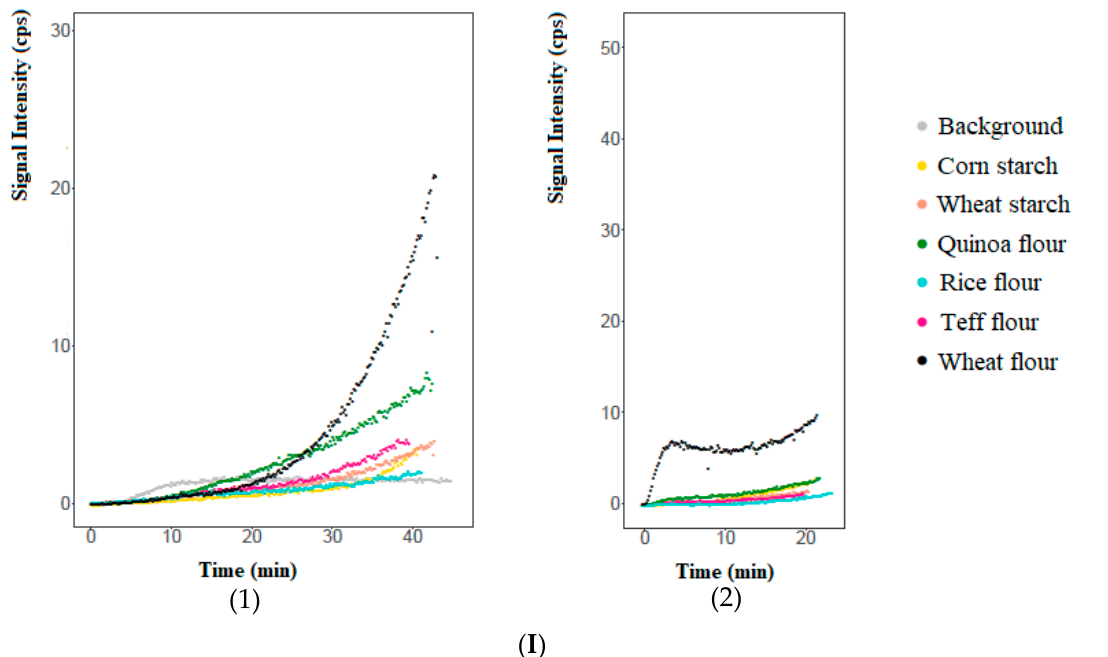
Figure 1. PTR-ToF-MS on-line curves of the volatile compounds released during 40 min. of baking ( 1 ) and further 20 min. of toasting ( 2 ). X -axis shows the time of baking/toasting, while Y -axis shows the signal intensity (cpu). Data corresponding to one compound were reported as an example of each of the 9 groups (classified by their biological origin): 3-methyl-1-butanol (fermentation origin, group 1, A ), 1-hexanol (lipids oxidation origin, group 2, B ), ethyl octanoate (esters origin, group 3, C ), hexanoic acid (group 4, D ), phenylethyl alcohol (fermentation-Maillard high retention in bread origin, group 5, E ), acetic acid (fermentation-Maillard low retention in bread origin, group 6, F ), 2,3-diethylpyrazine (early Maillard origin, group 7, G ), 2-acetyl-1-pyrroline (late Maillard origin, group 8, H ), furfuryl alcohol (caramelization-Maillard origin, group 9, I ).